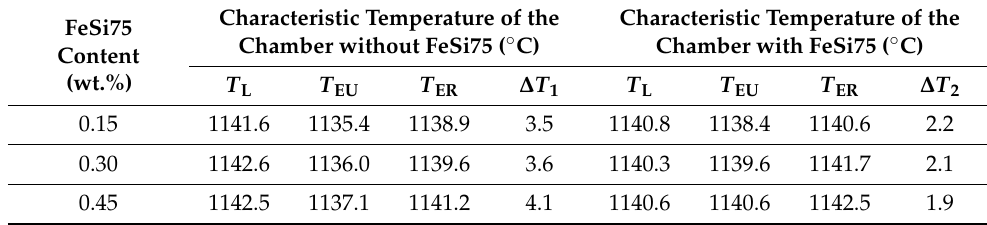
Table 5. Important characteristic values of the curves with different amounts of FeSi75. FeSi75 Content